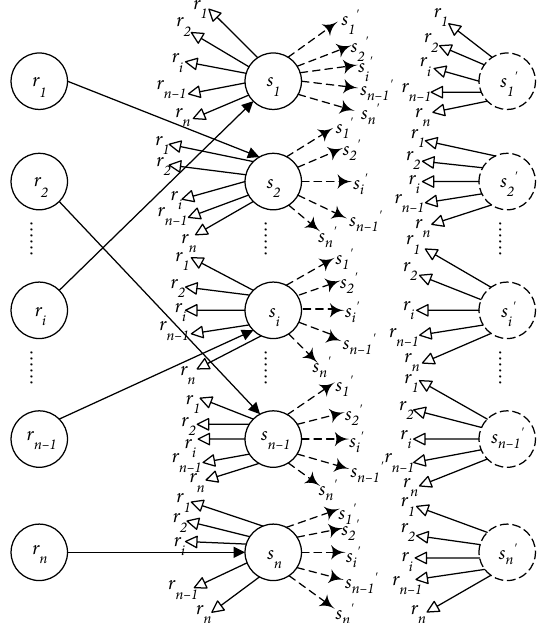
Figure 3: The network diagram for the path of gantry